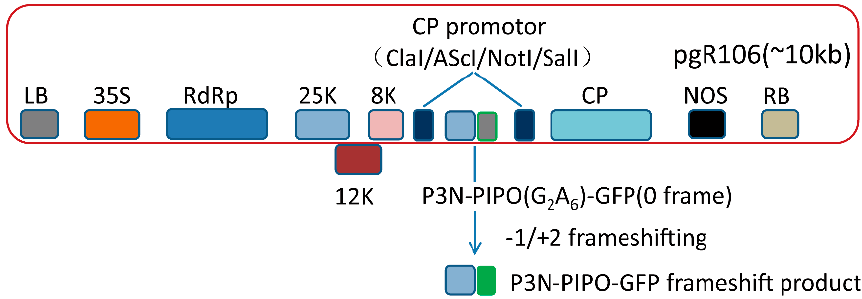
Figure 1. The schematic diagram of P3N-PIPO frameshift expression vector.